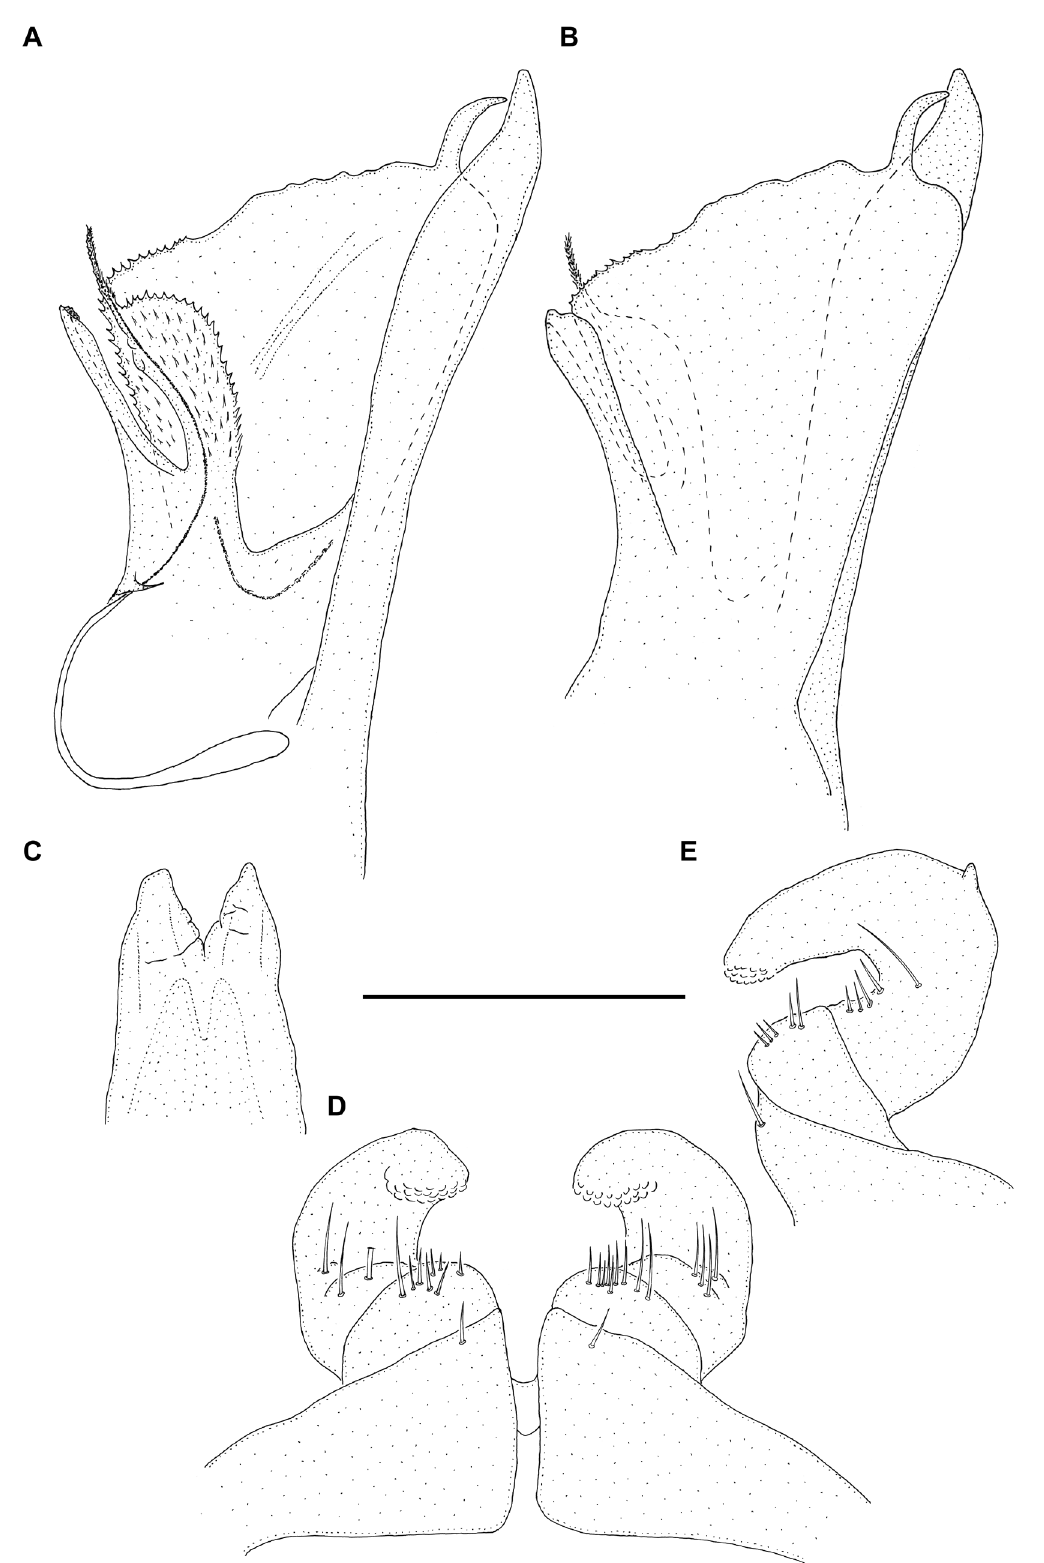
Fig. 24. Leucogeorgia golovatchi sp. nov., type ♂♂ from Tsakhi Cave (ZMUM). A . Holotype, right gonopods, mesal view. B . Holotype, left gonopods, lateral view. C . Paratype, penes, posterior view. D . Paratype, leg-pair 1, anterior view. E . Right leg 1, lateral view. Scale bar: 0.3